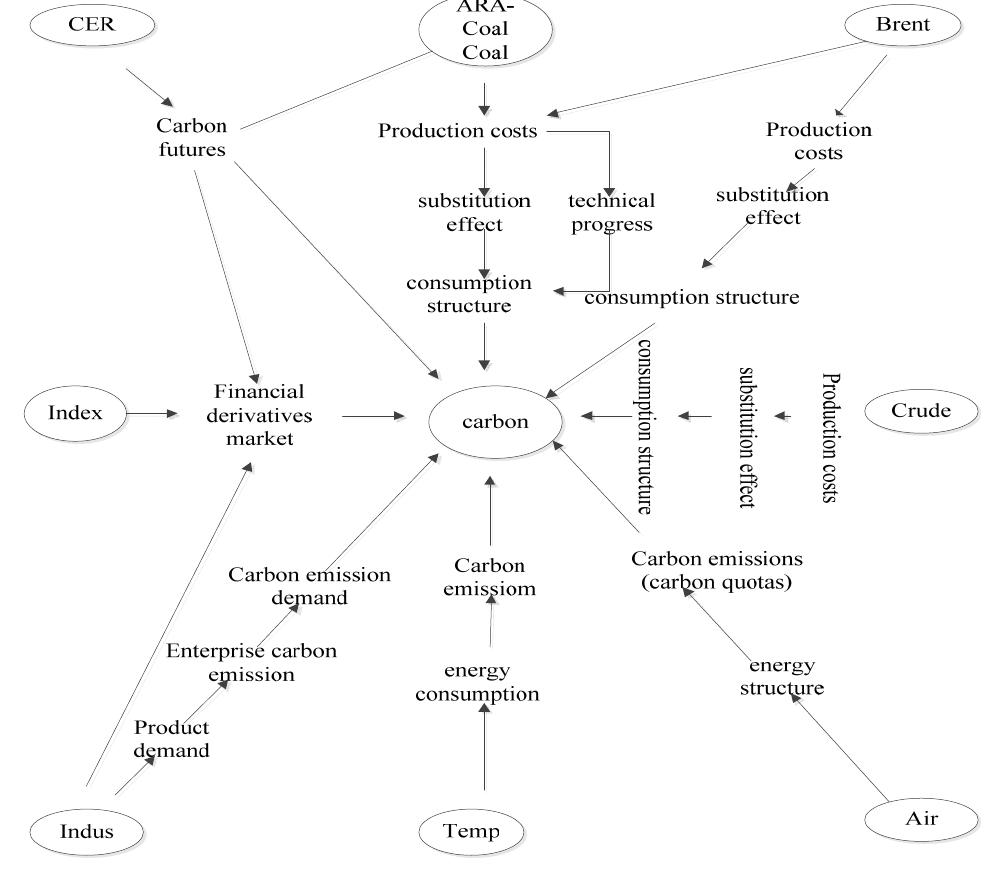
Figure 2. Effect mechanism of carbon price drivers.